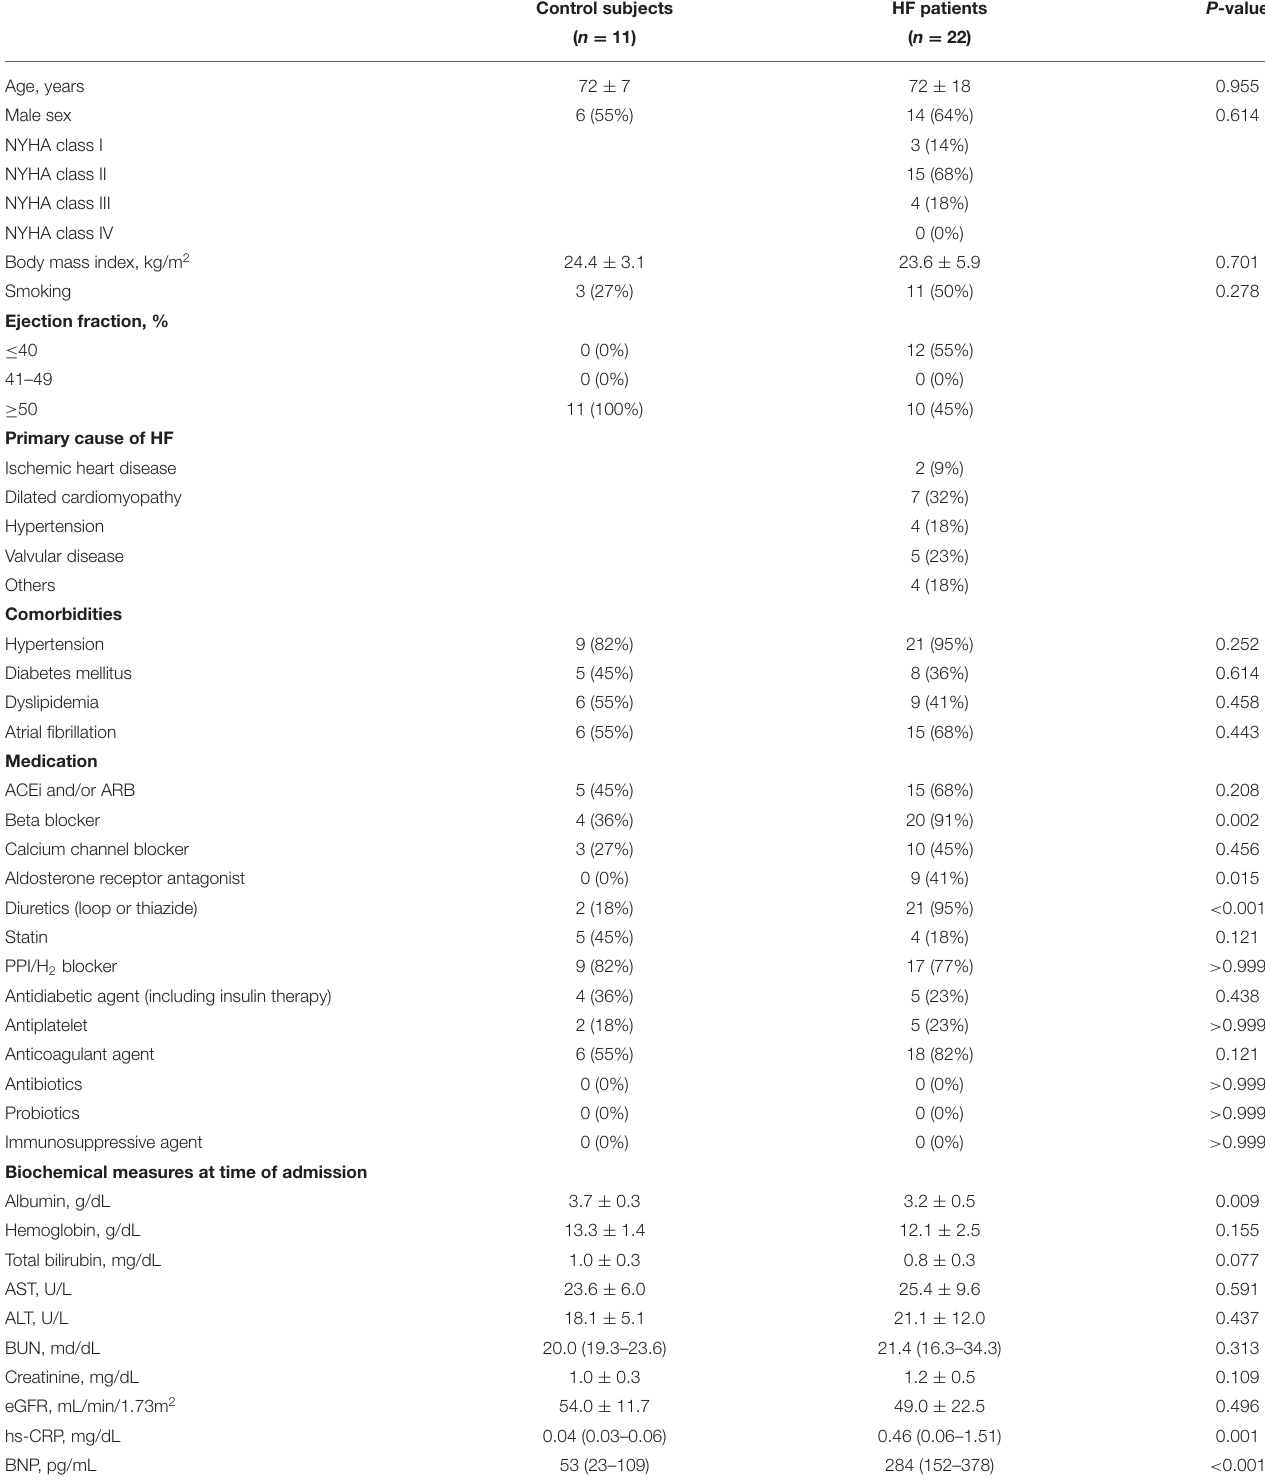
TABLE 1 | Patient